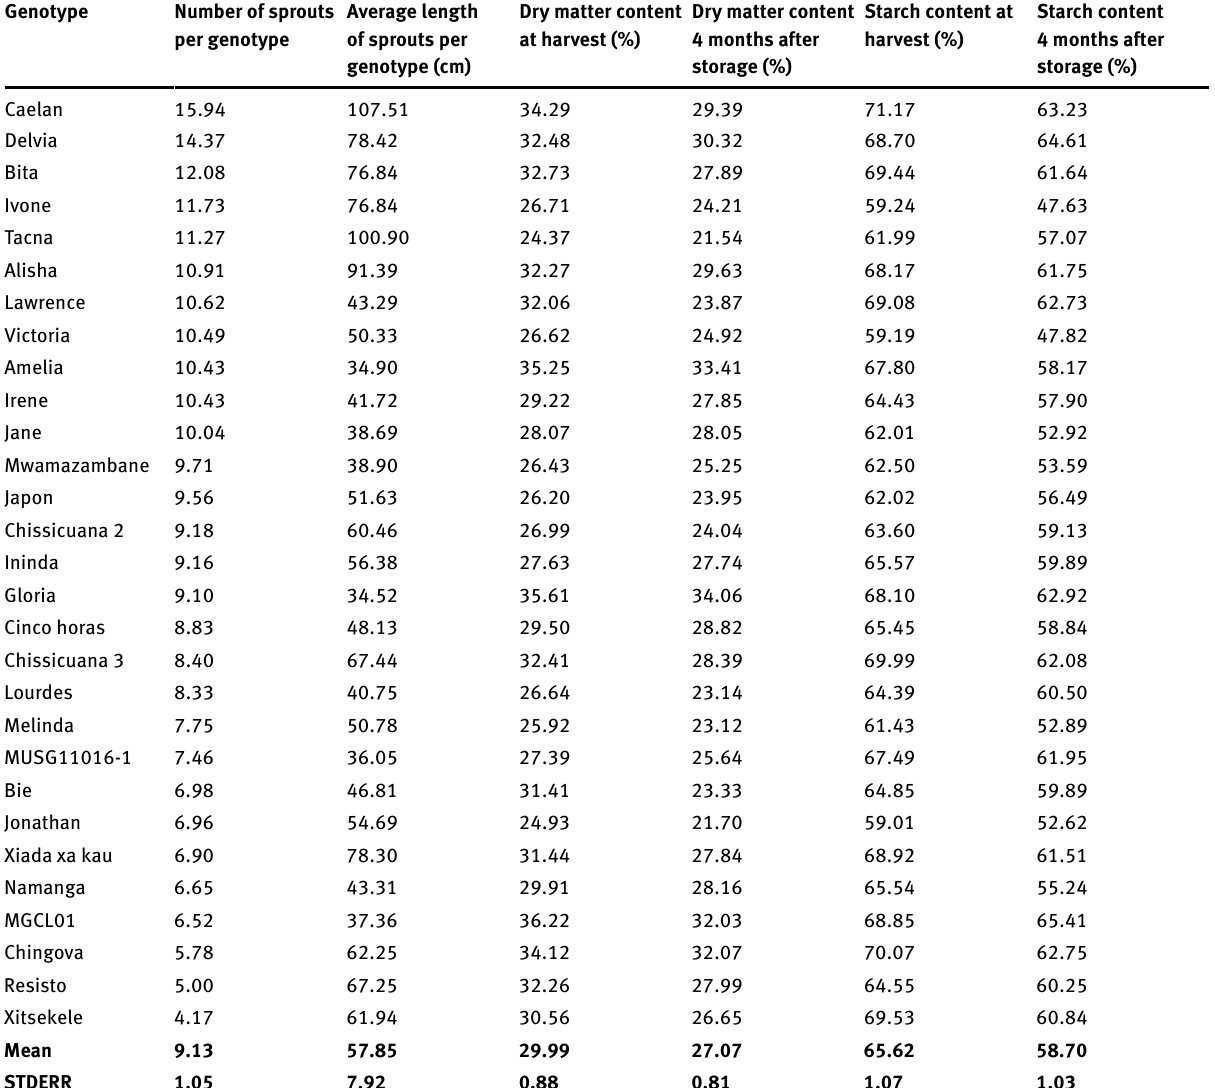
Table 6 : Genotypic means for number of sprouts per genotype, length of sprouts at six weeks after sprouting (cm), dry matter content at harvest and four months after storage (%), starch content at harvest and four months after storage (%) analysed between locations (Umbe- luzi Research Station and Nwalate Farm) and across the three years of evaluation (2015, 2016 and